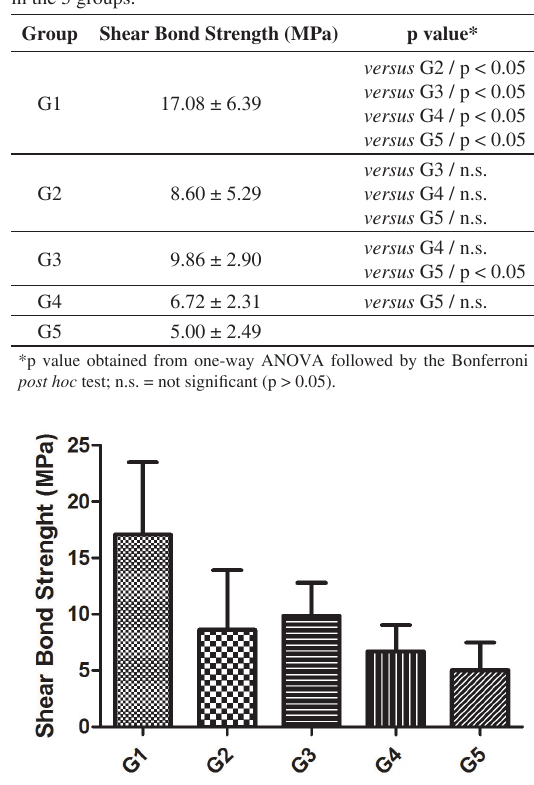
Figure 2. Means and standard deviations of shear bond strenght measured in the 5 groups under